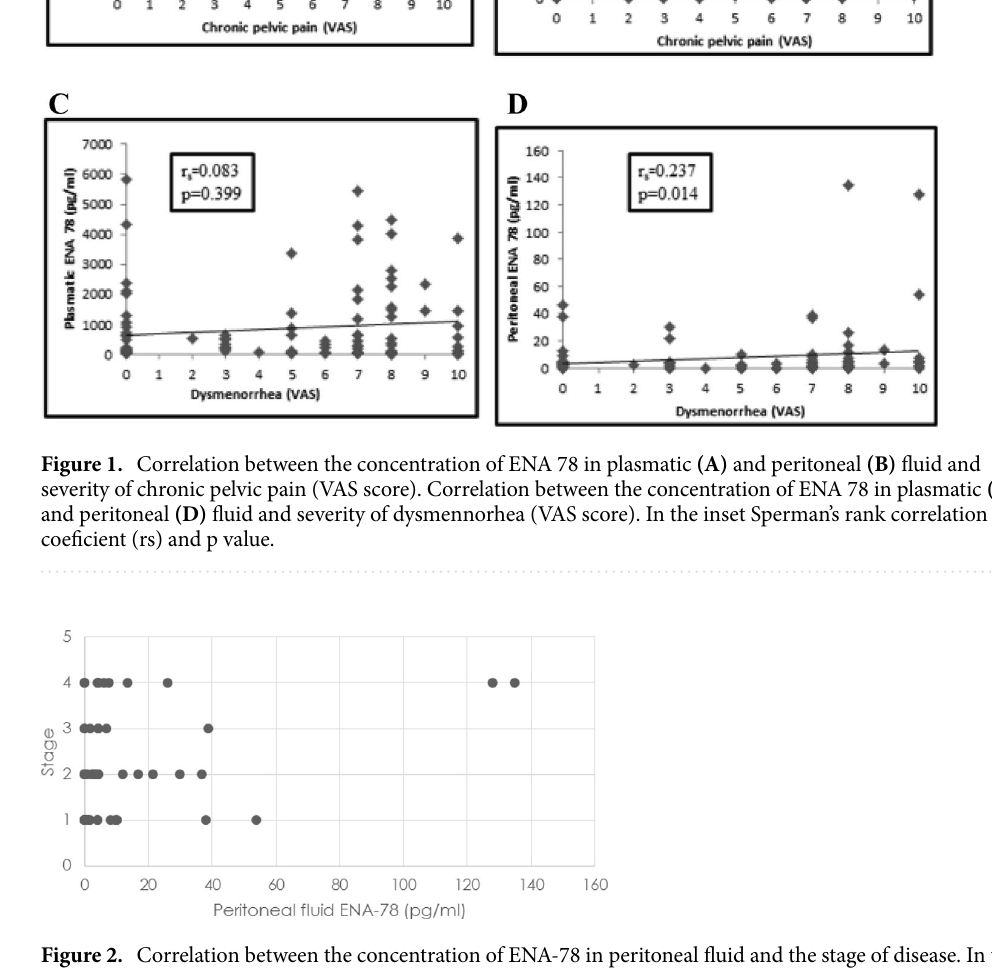
Figure 2. Correlation between the concentration of ENA-78 in peritoneal fluid and the stage of disease. In the inset Sperman’s rank correlation (r s = 0.488)) coeficient and p value (p =